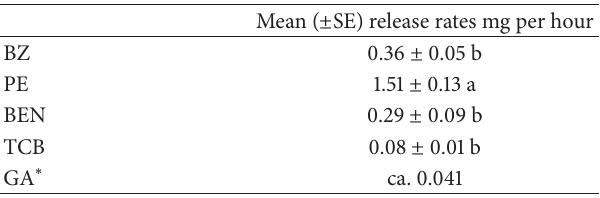
Table 3: Release rates of the tested commercial lures and synthetic pure compounds under laboratory